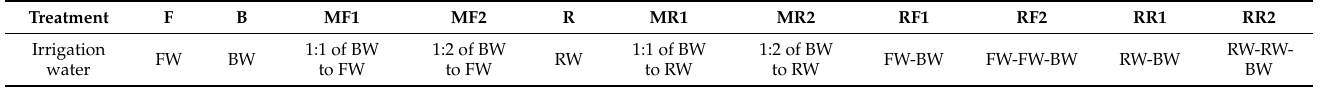
Table 2. The established treatments of pot experiment for combined irrigation.